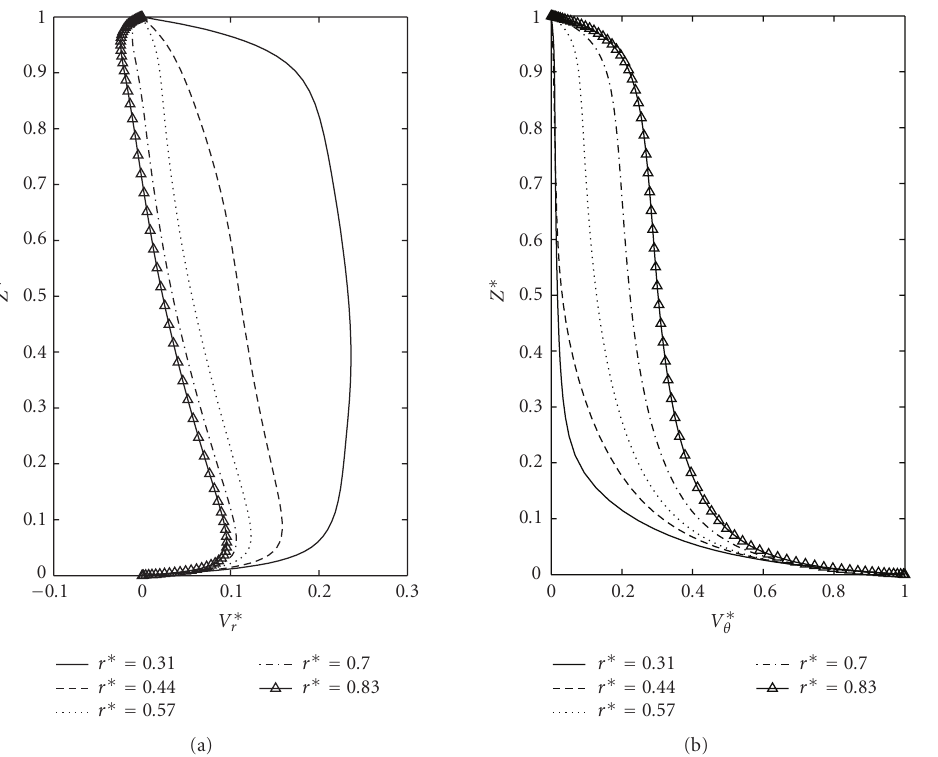
Figure 15: Axial profiles of the mean radial and tangential velocity components for Re = 10 6 , G = 0 . 02, and C w = − 2500 at di ff erent radial locations r ∗